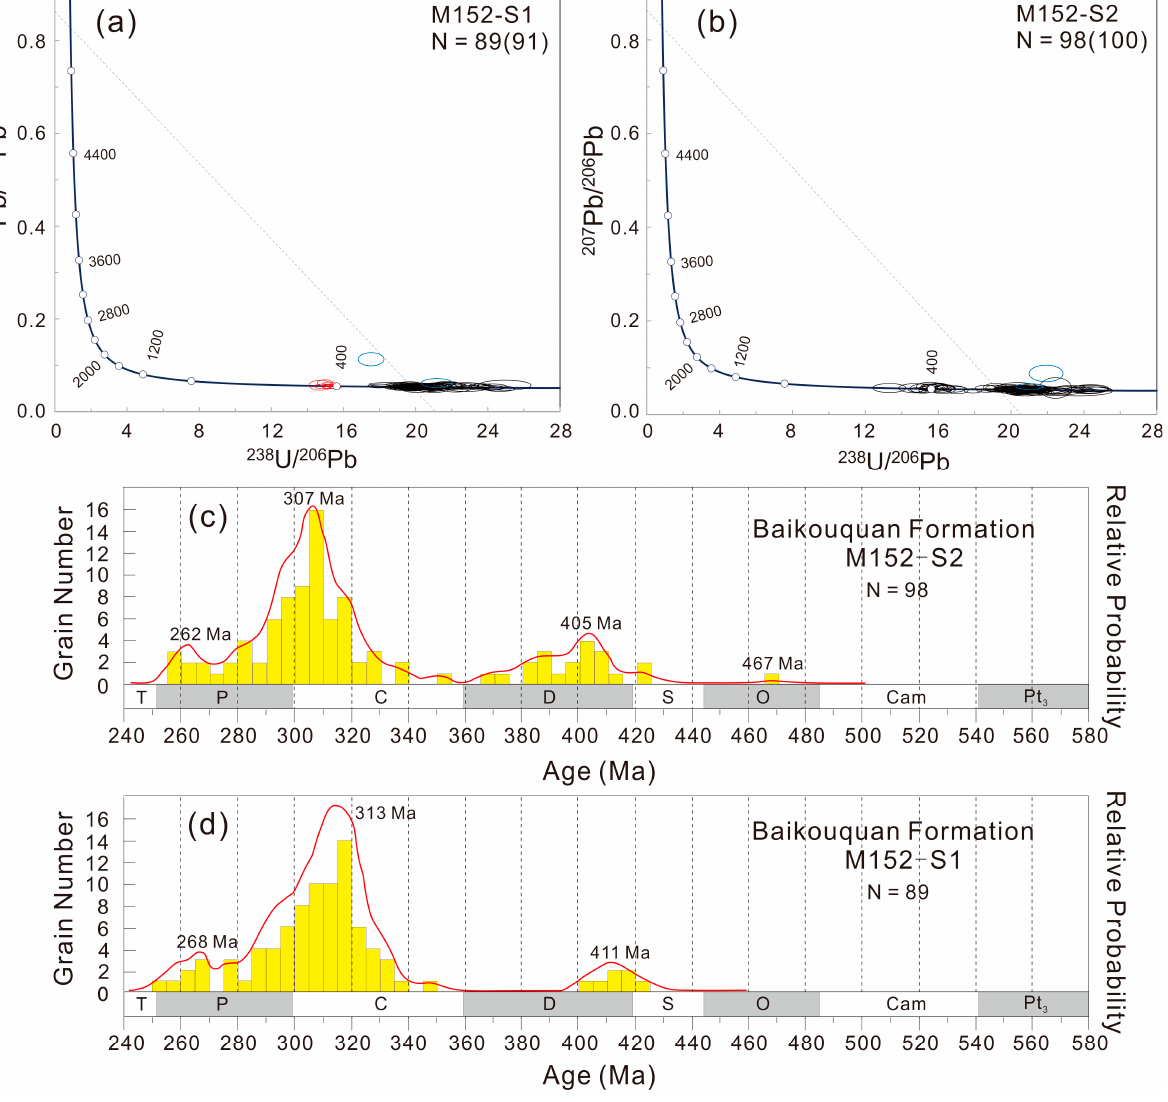
Figure 6. U-Pb dates Tera – Wasserburg plot ( a , b ) and relative probability density distribution ( c , d ) for detrital zircons from the Baikouquan Formation